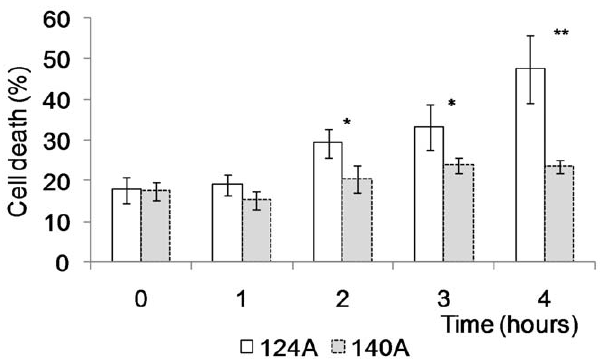
Figure 7. InvitroC.albicans macrophage killing. Cells from the macrophage cell line J774 were incubated with C. albicans isolates 124A or 140A cells in a ratio of 1:5 (E:T) and dead macrophages identified after incubation with 1 m g/ml of propidium iodide under the florescence microscope. Statistically significant differences between results at each hour of co-infection, as evaluated by Student’s t test, are labeled with single asterisk ( P , 0.05).